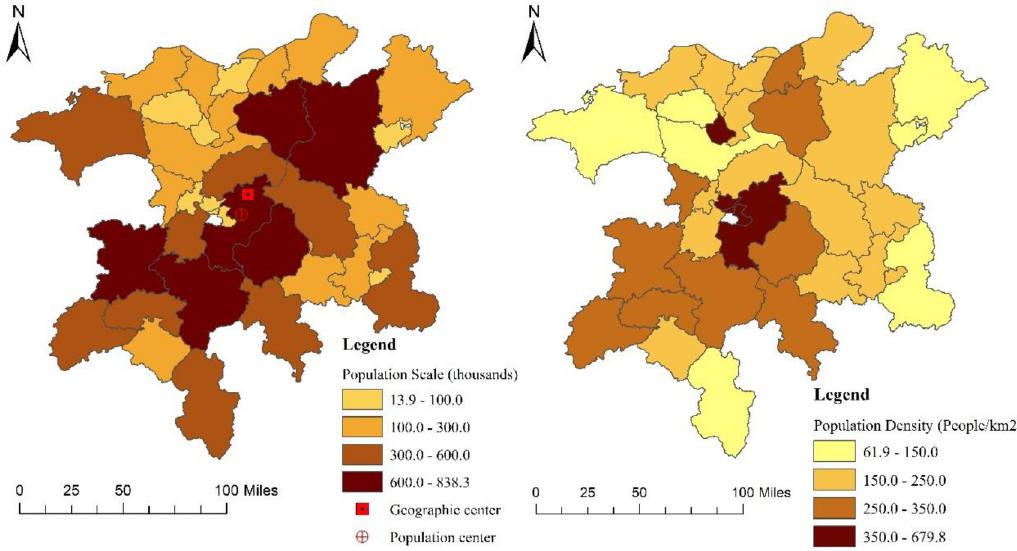
Fig 2. Spatial distribution of county population size and